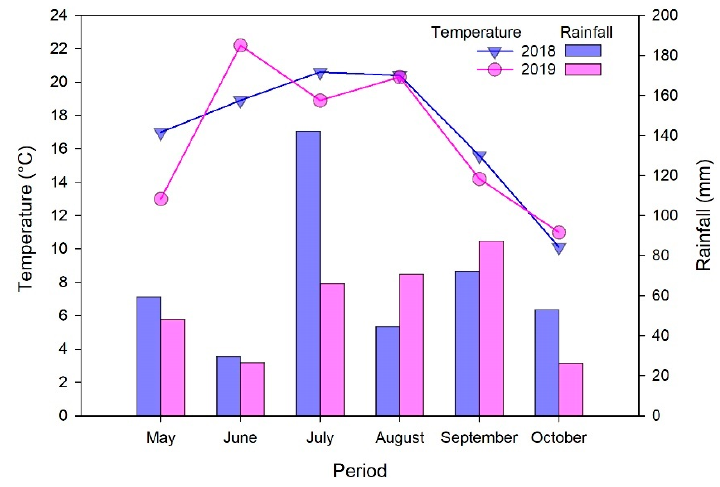
Figure 1. Monthly mean air temperature and monthly sum of precipitation recorded during the 2018 and 2019 seasons at the experiment site.